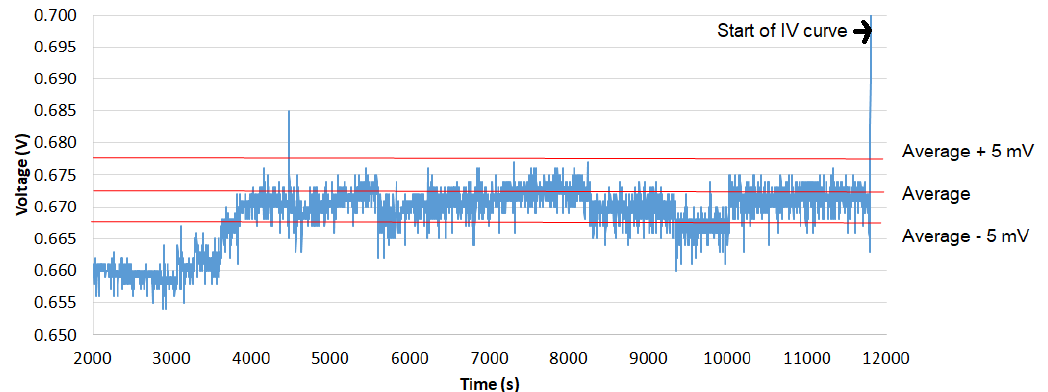
Figure A2. Evolution of the cell voltage during the cell conditioning step. The +/ − 5 mV range is marked in red.